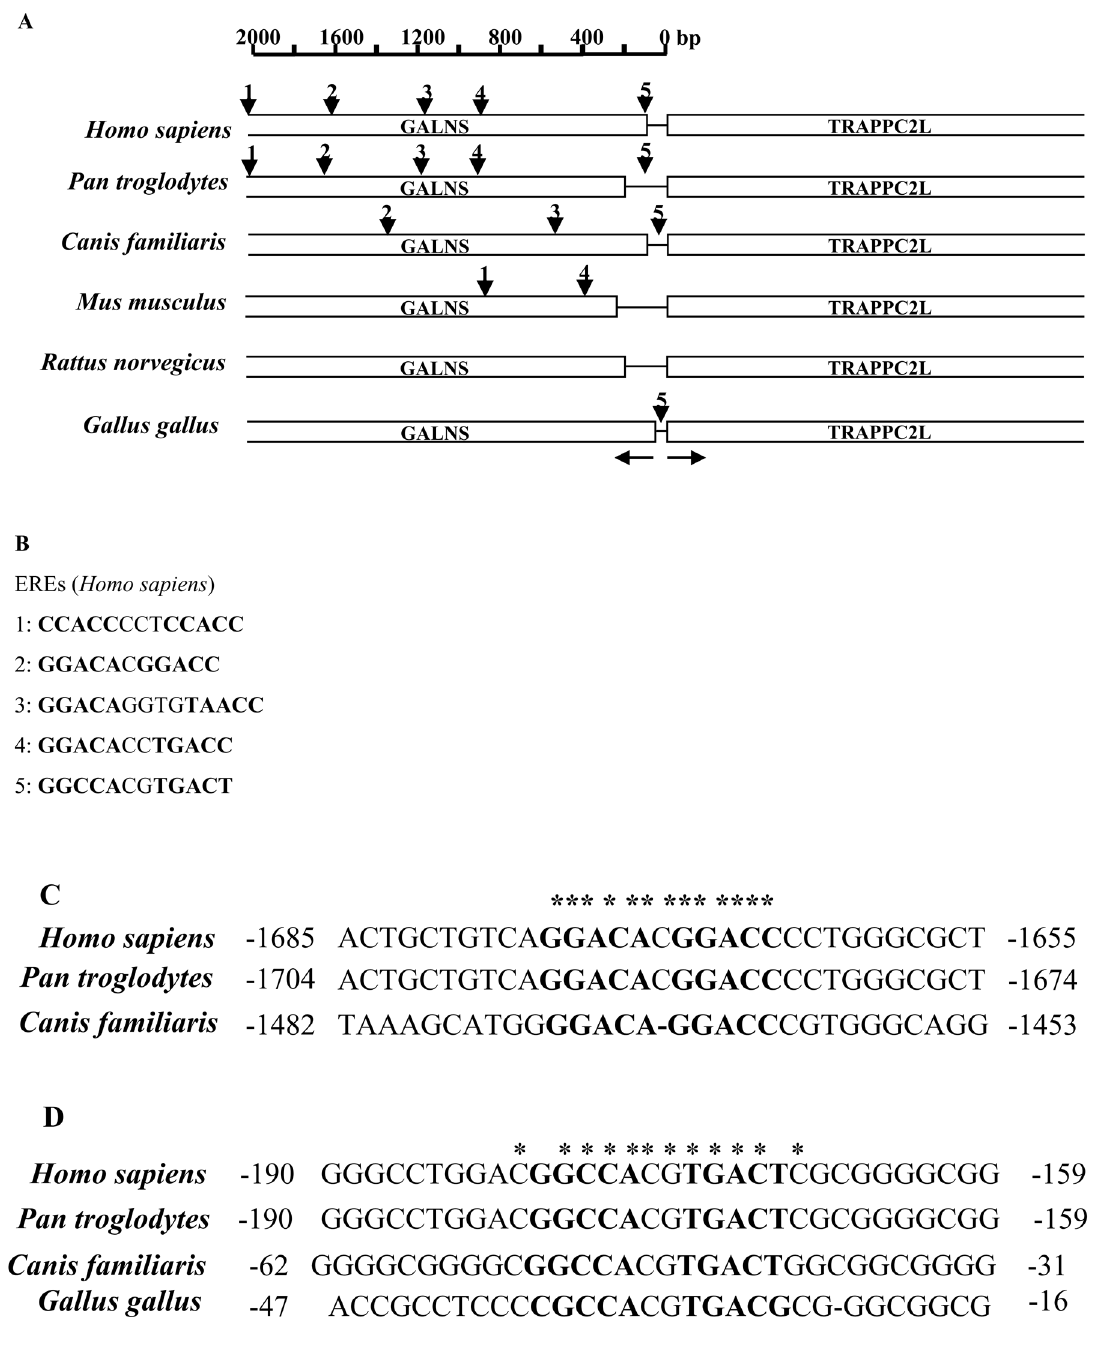
Figure 3. Evolutionarily conserved estrogen receptor binding elements (EREs) in the potential promoter region of the bidi- rectional gene pair GALNS/TRAPPC2L across vertebrates. A , Schematic presentation of the bidirectional gene pair GALNS/ TRAPPC2L in humans, chimpanzees, dogs, rats, and chickens. The black arrows and numbers 1 to 5 indicate the location of conserved EREs relative to the position of the transcript start site in the TRAPPC2L gene. B , 1 to 5 ERE sequences; EREs 2 (C) and 5 (D) and the surrounding sequences are shown in the alignment. The half-EREs are in bold. Asterisks denote highly conserved